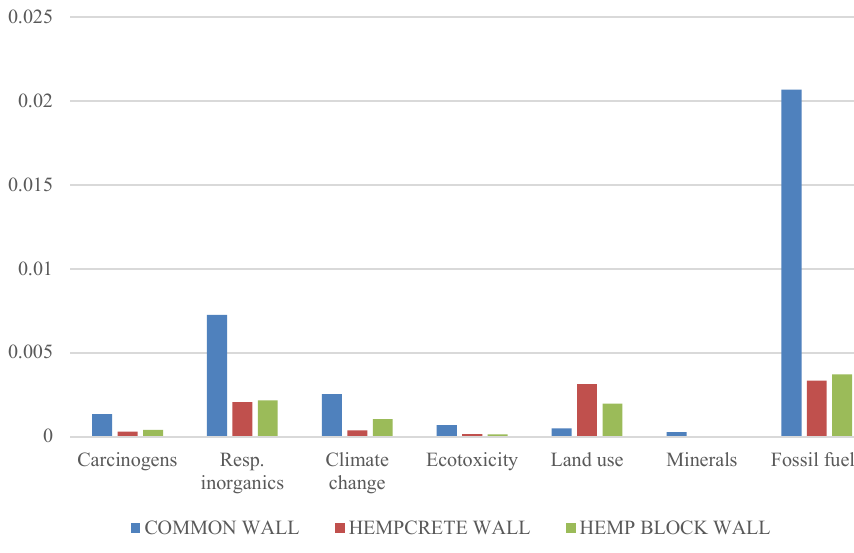
Fig. 3 Comparison among 1 m 2 of hempcrete wall, hemp blocks wall, common wall – Method Ecoindicator 99. Fig. 4 shows the results of the comparison using the Cumulative Energy Demand